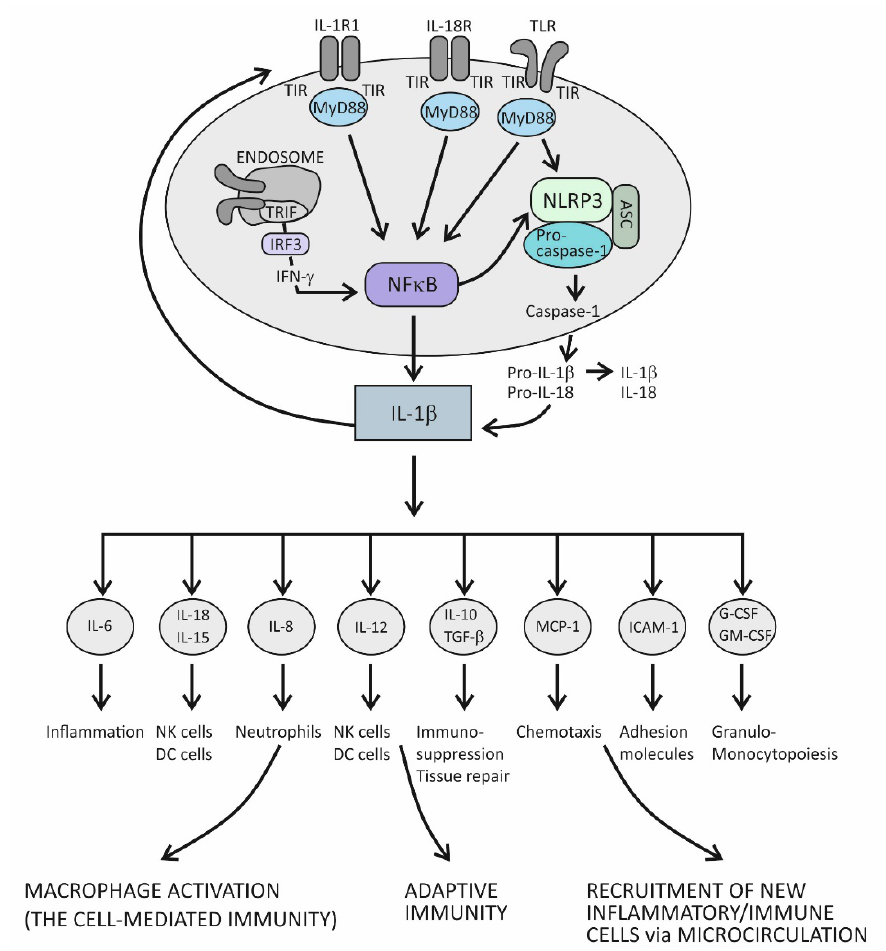
Figure 1. The role of the IL-1 cytokine family in promoting inflammation.